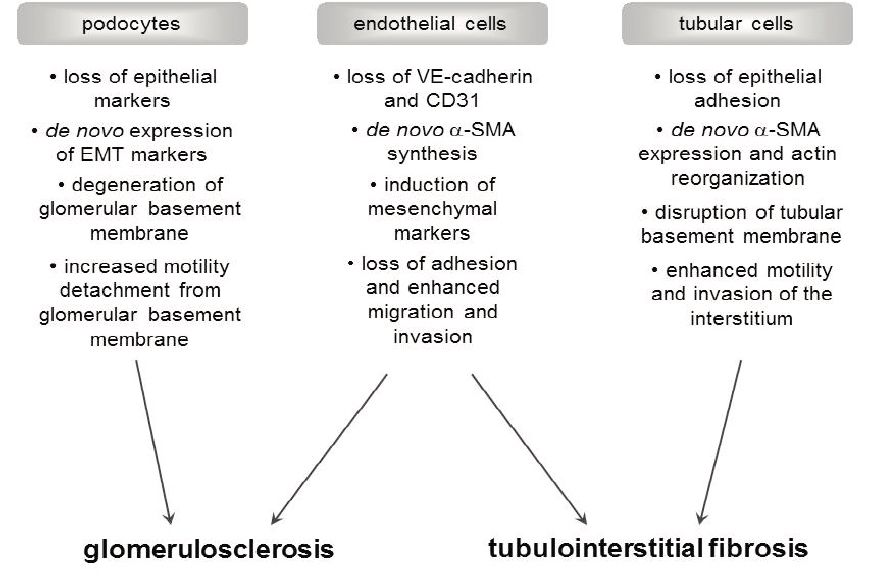
Figure 3. Hypothesized progression of fibrosis by EMT and EndoMT in the interstitium or in the glomerulus. The illustration shows four key events essential for the completion of EMT and EndoMT, which lead to glomerulosclerosis and tubulointerstitial fibrosis. For more details see the text